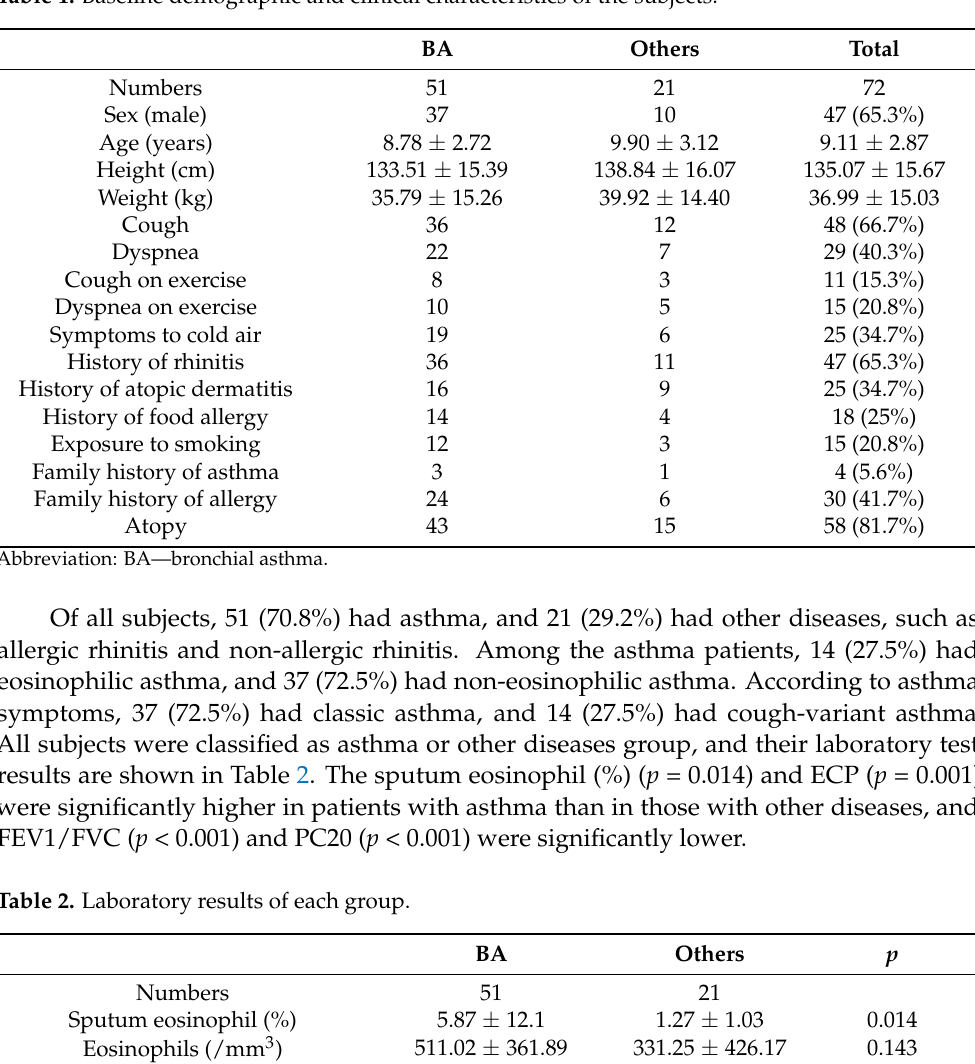
Table 1. Baseline demographic and clinical characteristics of the subjects.